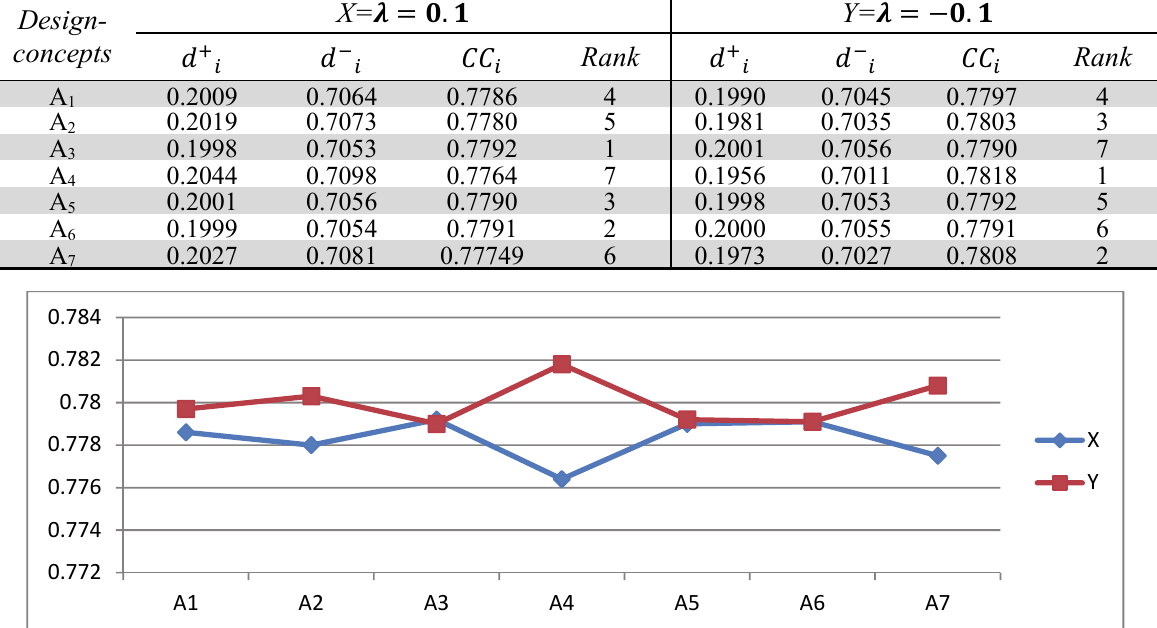
The relative closeness coefficients for the design evaluation for the Forklift Machine Design-